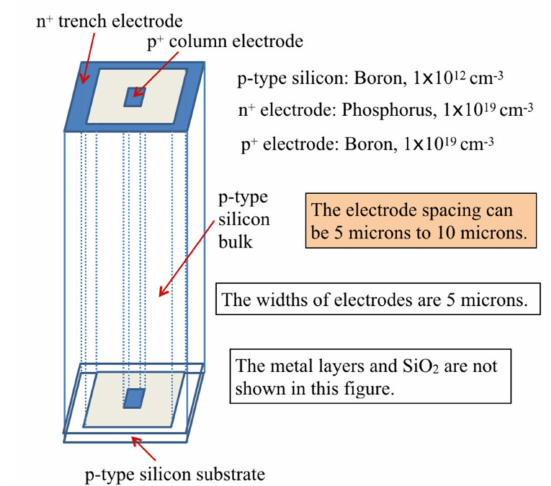
Figure 1. Square ultra-fast 3D-trench electrode detector